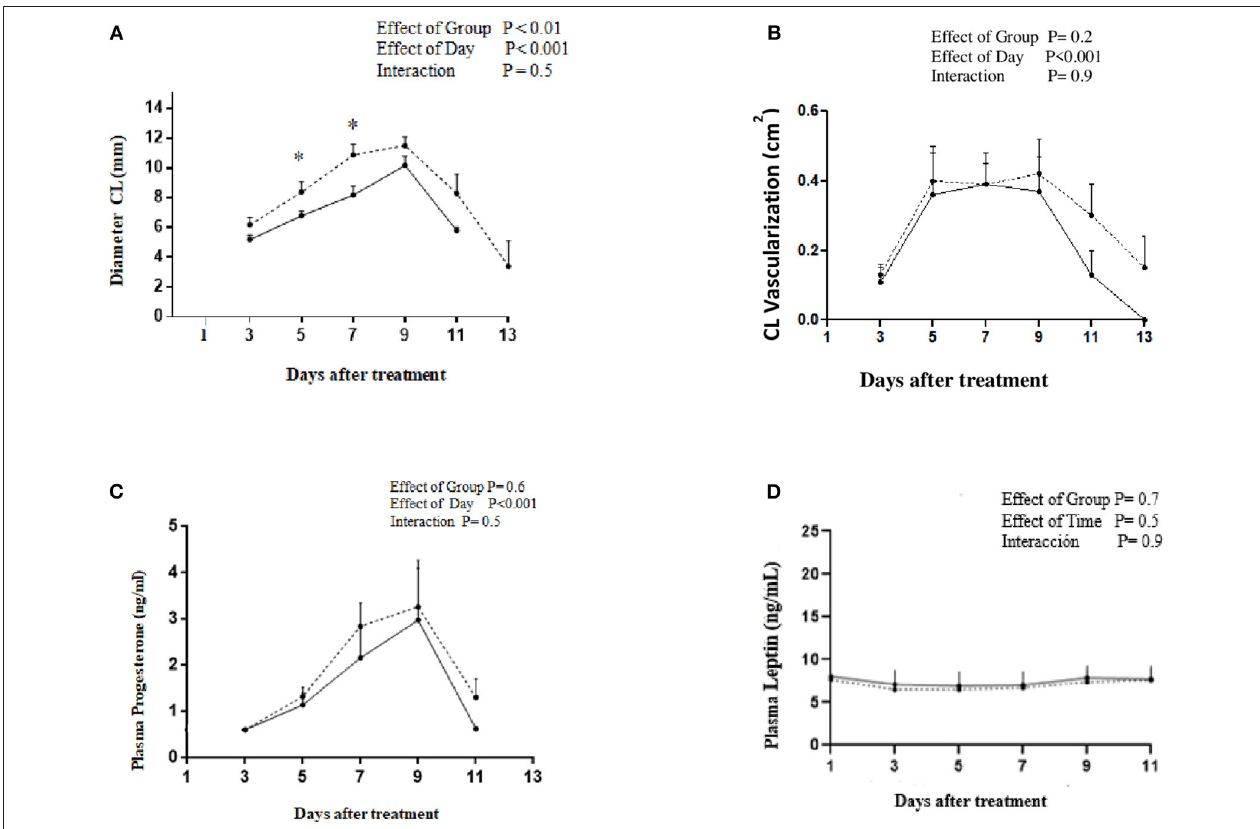
FIGURE 2 | Profiles of (A) CL diameter, (B) CL vascularization, (C) plasma progesterone concentration, and (D) plasma leptin concentration after treatment with GnRH to induce ovulation in alpacas under energy restriction 40% (______, n = 7) or fed ad libitum (-------, n =